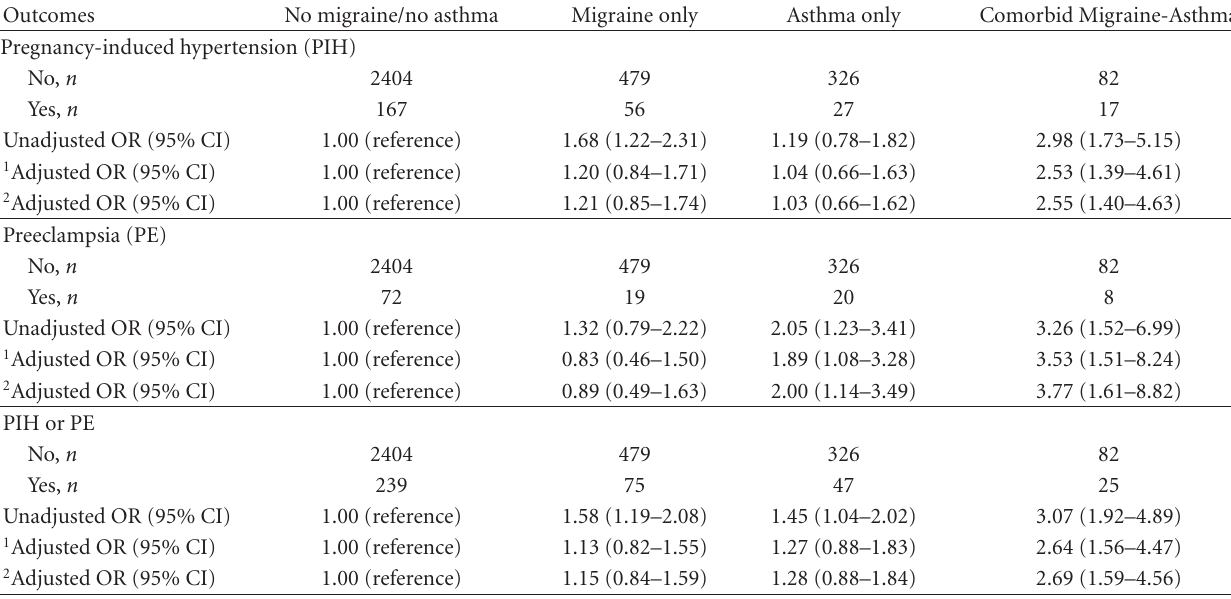
Table 3: Unadjusted and adjusted odds ratios (ORs) and 95% confidence intervals (CIs) of hypertensive disorders of pregnancy in relation to maternal migraine and asthma status, Seattle and Tacoma, WA, USA,